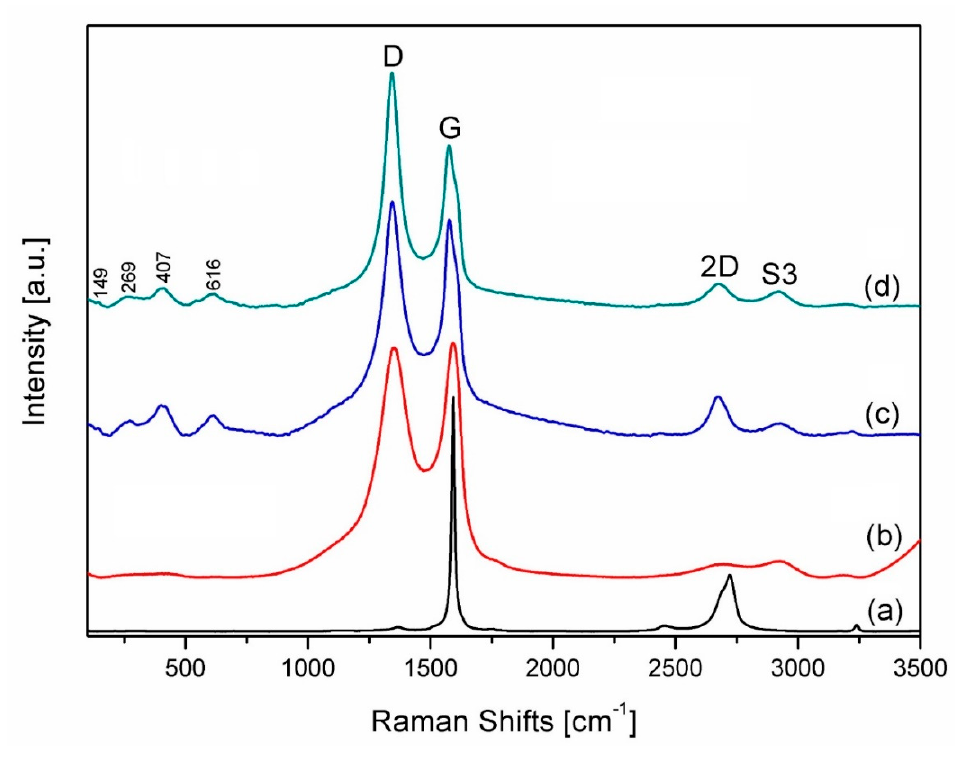
Figure 2. Raman spectra of starting graphite powder ( a ), graphene oxide ( b ), synthesized ZrO 2 / GO ( c ) and ZrO 2 / rGO ( d ) nanopowders. “D”, “G”, “2D” and “S3” correspond to the graphene-based structure.